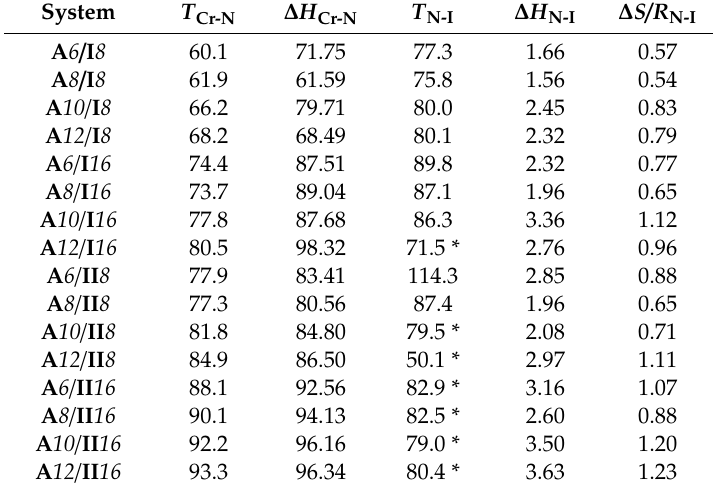
Table 2. Phase transition temperatures ( ◦ C), enthalpy of transitions (kJ / mol) and normalized entropy change for the supramolecular complexes A n / I m and A n / II m .